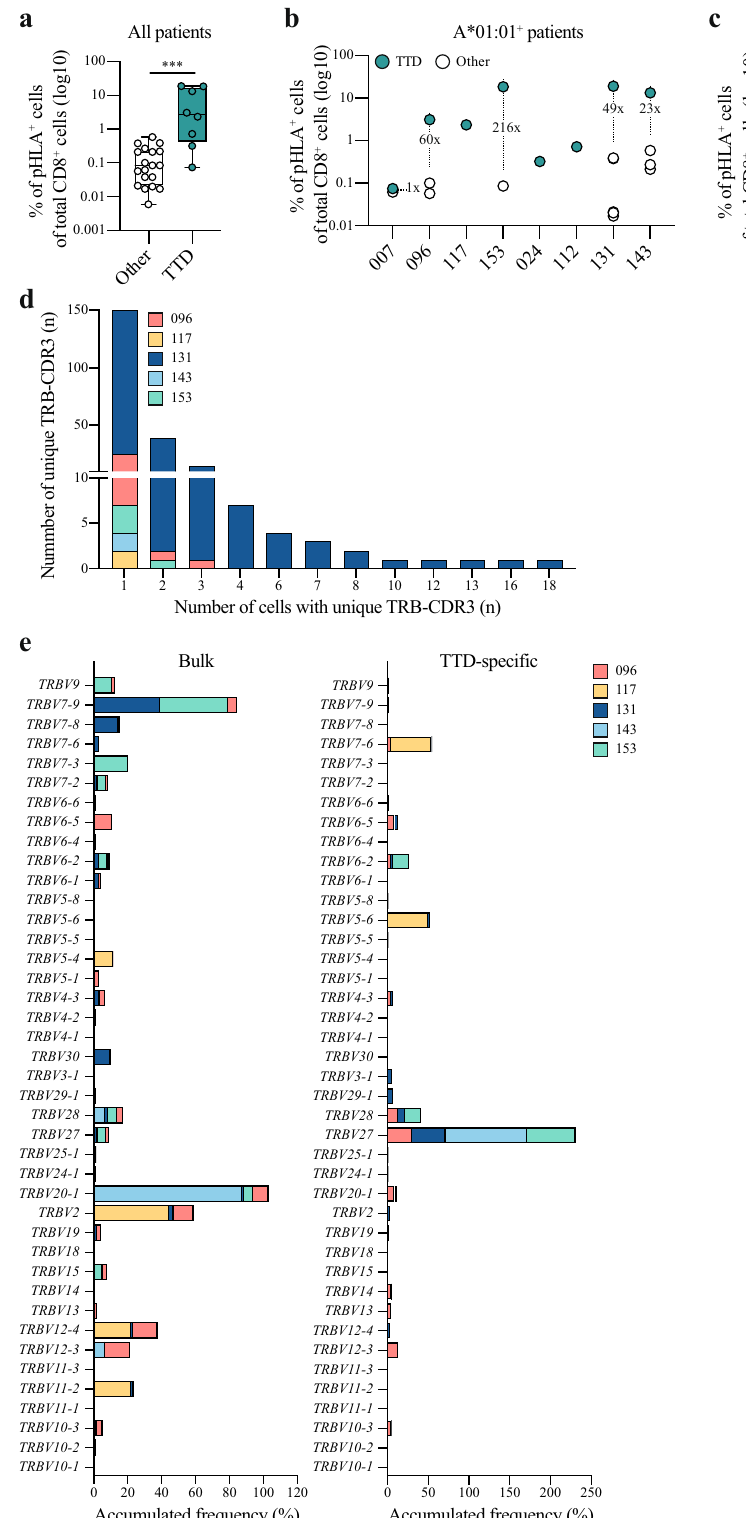
Dysfunctional state of SARS-CoV-2-speci fi c CD8 T cells . To characterize the identi fi ed SARS-CoV-2-speci fi c CD8 T cell response, we fi rst assessed the functionality based on cytokine production of interferon- γ (IFN γ ), tumor necrosis factor (TNF), interleukin (IL)-2, and IL-17 upon stimulation with cognate peptide. The functional assay was focused on the TTD-speci fi c